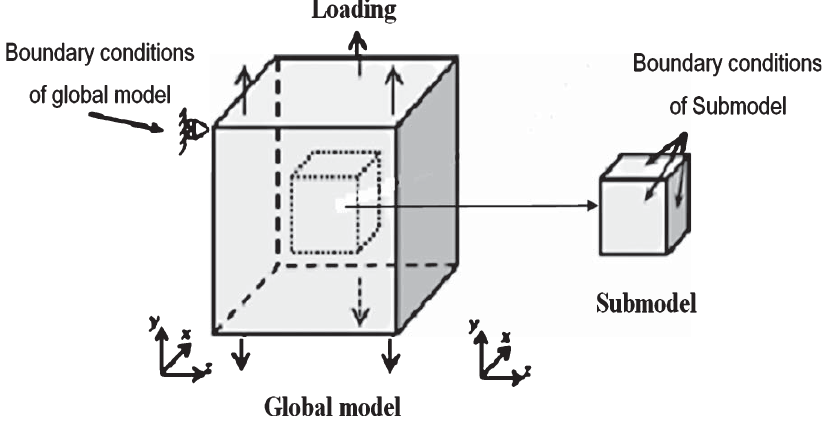
Fig. 5. Example schematic of a global model and submodel. The computed displacements on the global model are interpolated on the submodel